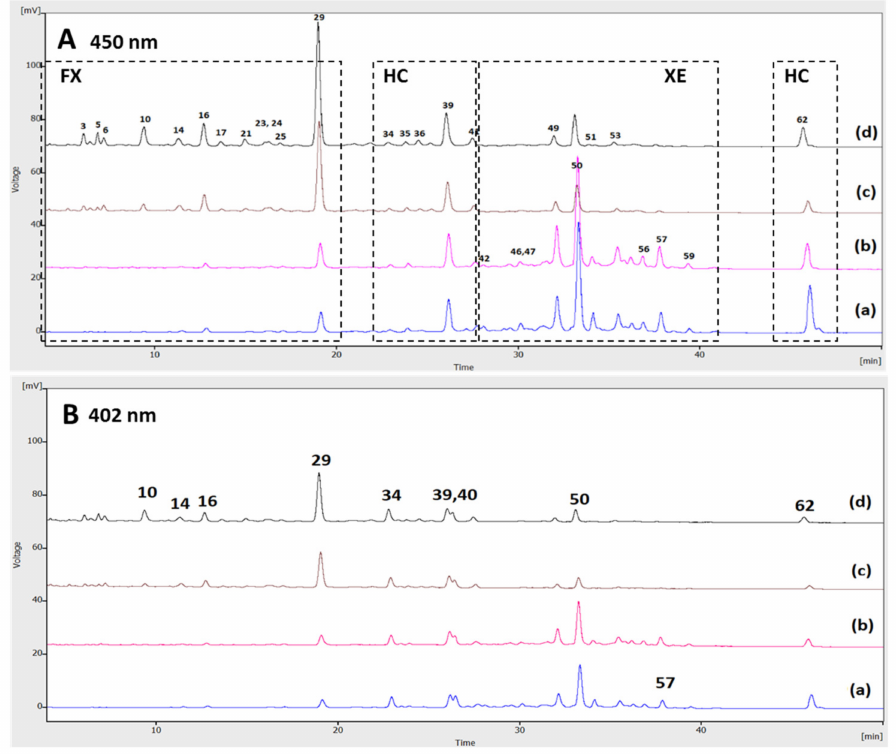
Figure 6. RP-(C30)-HPLC carotenoid profile at ( A ) 450 and ( B ) 402 nm. Chromatographic traces from bottom to the top represent untreated persimmon pulp (PP) ( a ) and persimmon juice residues (PJR) after microwave heating of the pulp for ( b ) 30 s: PJR-M30; ( c ) 60 s: PJR-M60; and ( d ) 120 s: PJR-M120. Each trace was divided in 62 sub-regions based on the elution time intervals of every carotenoid peak detected in the studied extracts. Further information about the elution order and spectral characteristics of the peaks is provided in Appendix A (Table